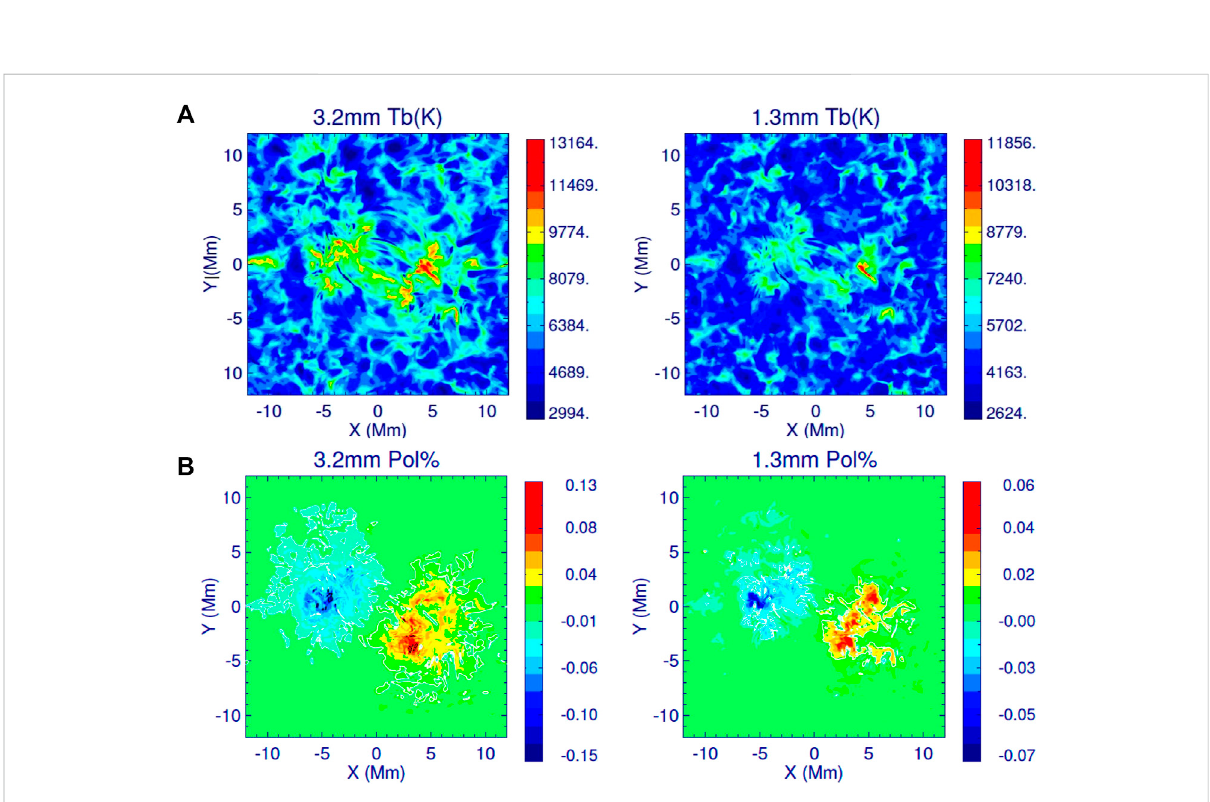
FIGURE 8 Model brightness temperature distributions forabipolar regions inBand3and Band6 (A) andthecorresponding degree ofcircular polarization (B) . After Loukitcheva et al.